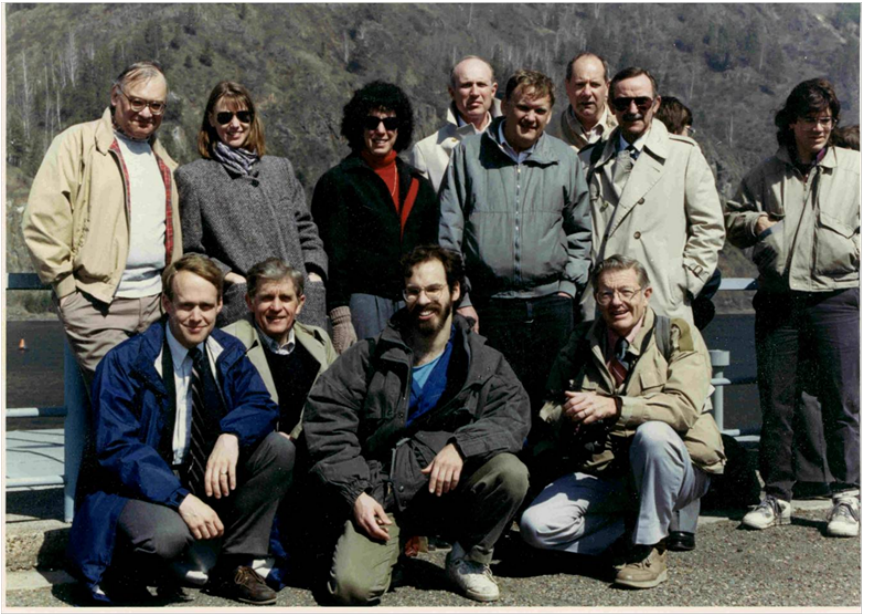
Figure 2. NASA program managers and researchers visiting Krasnoyarsk, Siberia to meet with the BIOS-3 researchers in 1989. Back row, from left to right: Dr. Mel Averner (NASA Headquarter); Dr. Penny Firth (Lockheed Martin Corp), Dr. Ellen Baker (NASA Astronaut), Dr.